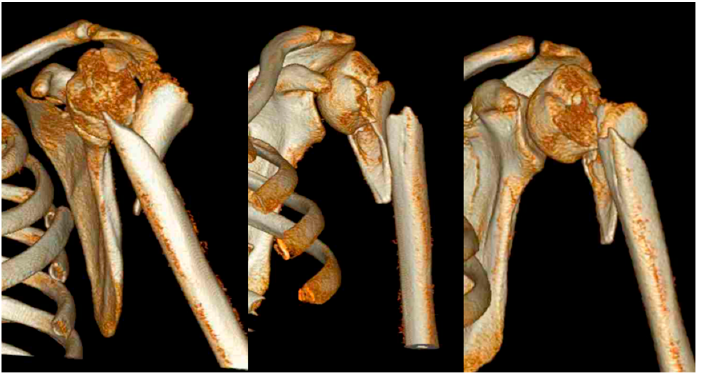
Figure 1. Example of a 3D computed tomography reconstruction of a combined intermuscular humerus fracture according to Garnavos et al. [6]. Shown is the typical intact bony segment between the fractured humeral head and the fractured diaphysis.